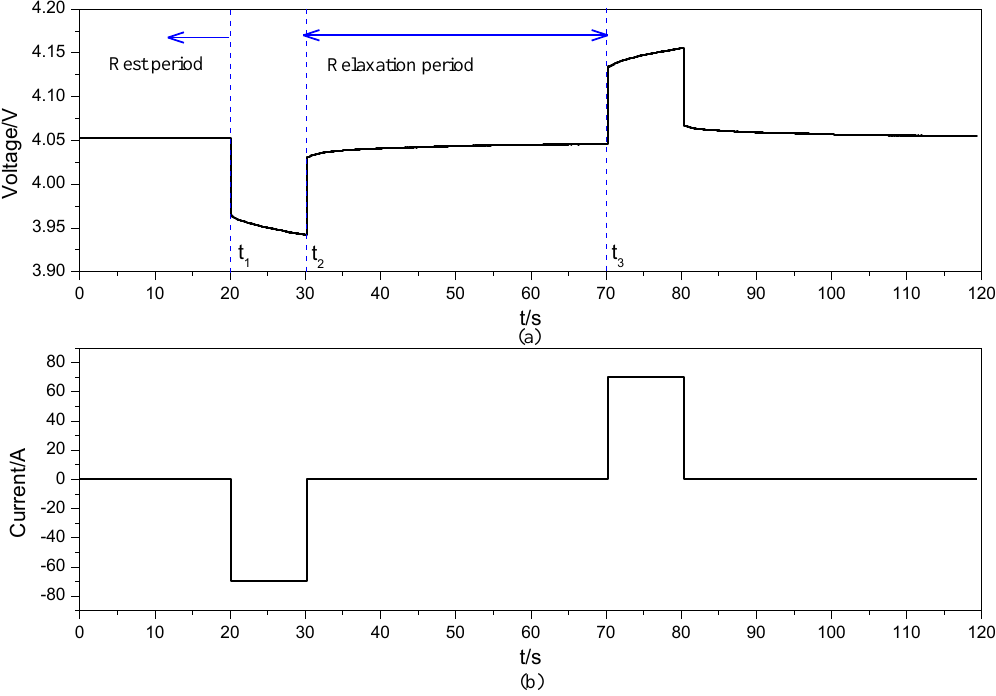
Figure 4. HPPC test curves: ( a ) voltage variation curve; ( b ) current variation curve. Only the test curves corresponding to the discharge pulse and its neighboring shelving period are used in this work. Before the HPPC test, there is a shelving period during